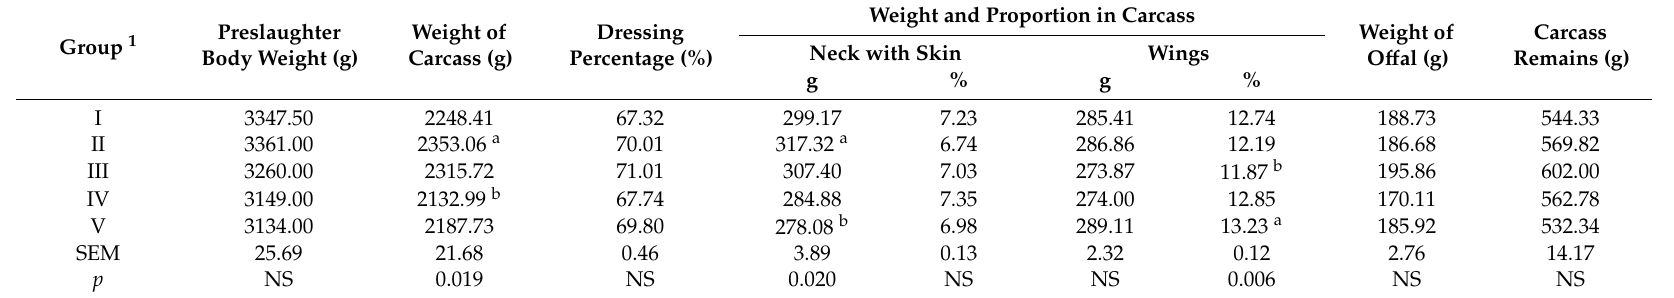
Table 5. Meat traits of 7-week-old